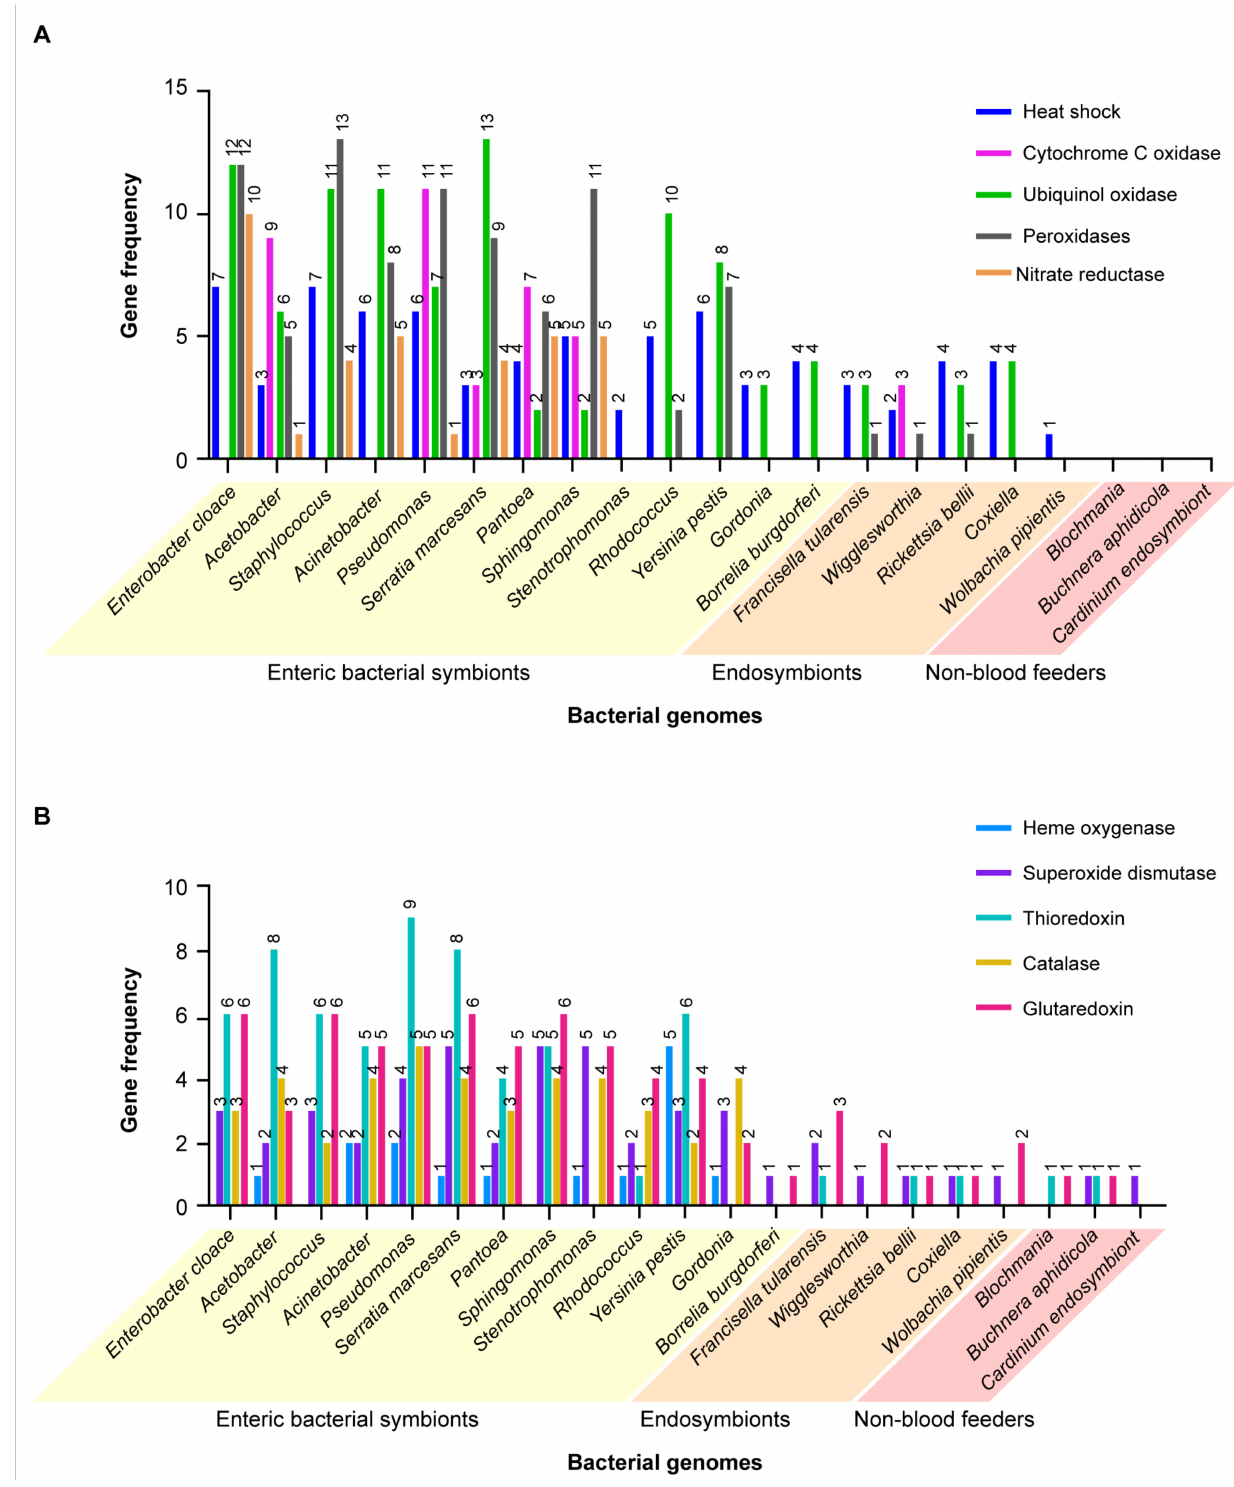
Figure 6. Comparison of the number of genes coding for different proteins for coping with various cell stressors expressed by 18 symbiotic bacteria in blood-feeding insects and ticks versus three symbiotic bacteria in plant-feeding insects. ( A ) Heat shock protein (mostly HSP60, HSP70 and HSP90), cytochrome C, ubiquinol, peroxidase and nitrate. ( B ) Heme oxygenase, superoxide dismutase, thioredoxin, catalase and